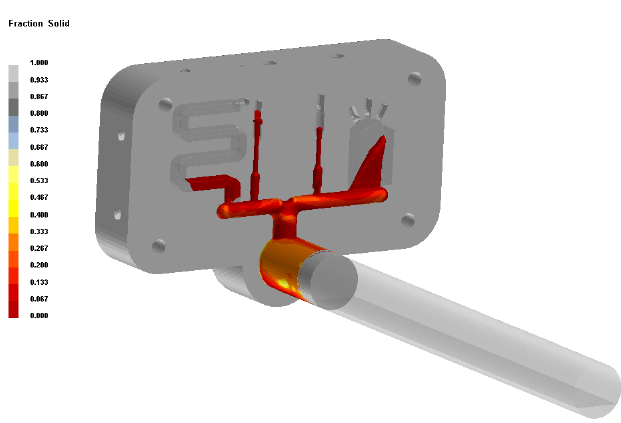
Figure 3. Example of the HPDC numerical